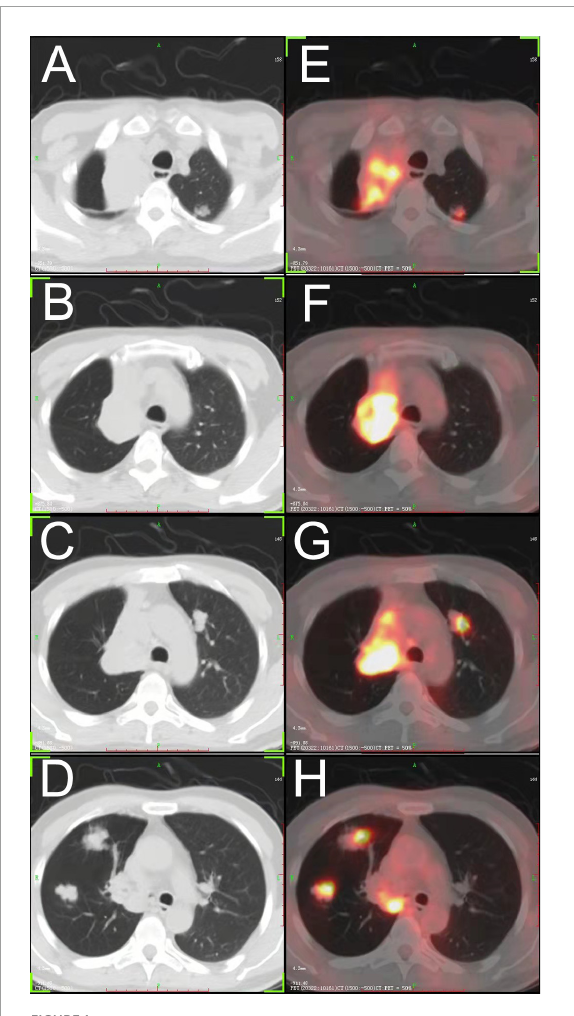
FIGURE1 (A–D) Chest CT showing a large tumor in the hilum of the right lung, and multiple bilateral pulmonary nodules. (E–H) FDG- positron emission tomography/CT showing high accumulation of FDG in each lesion. FDG,